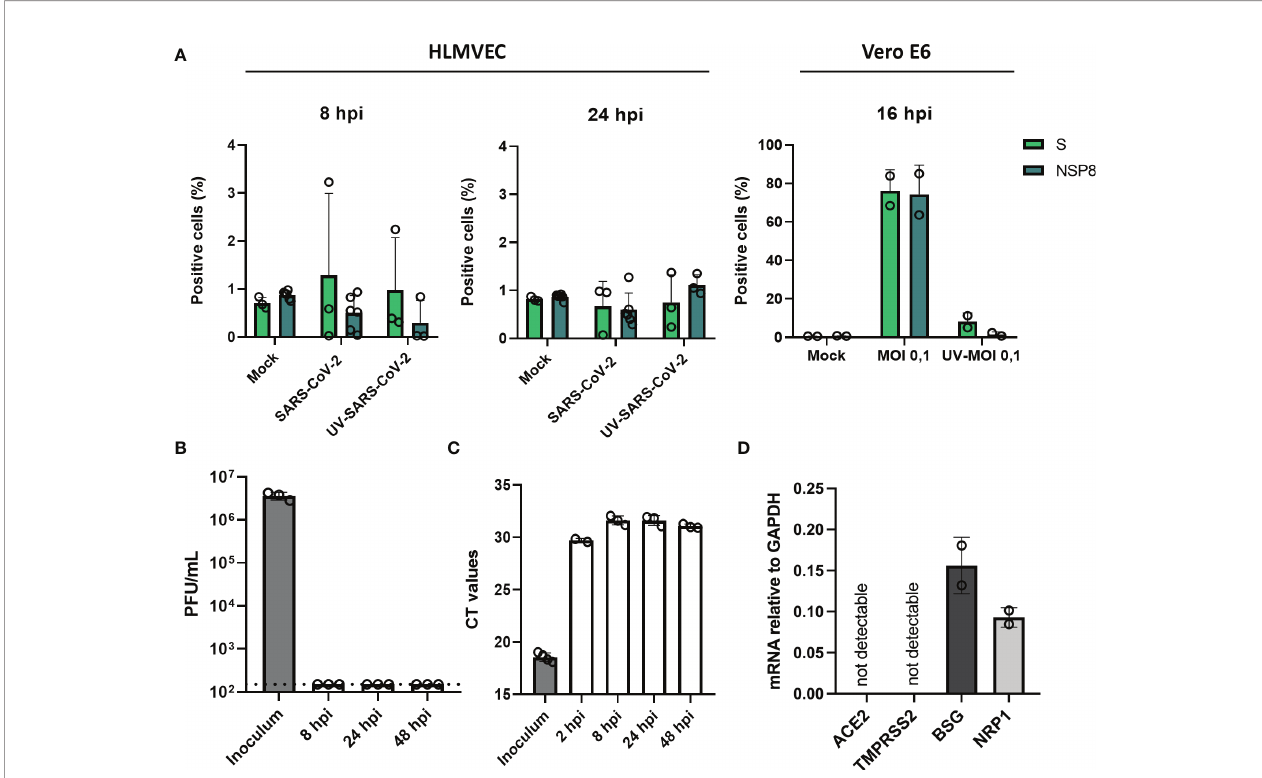
FIGURE 1 | SARS-CoV-2 does not infect HLMVEC. HLMVEC were inoculated with SARS-CoV-2 at MOI 5 for 8, 24 and 48 hr and Vero E6 cells were inoculated for 16 hr. (A) Percentage of infected cells was determined in HLMVEC 8 and 24 hpi and Vero E6 cells 16 hpi by the protein expression of NSP8 and S determined by fl ow cytometry. The production of new infectious virus (B) and viral RNA (C) was determined at 8, 24 and 48 hpi by plaque assay and qPCR respectively. The dotted line indicates the threshold of detection. Data are represented as mean ± SD of at least three independent experiments. Each symbol represents data from a single independent experiment. (D) The mRNA levels of ACE2, TMPRSS2, BSG and NRP1 were obtained by RT-qPCR. Gene expression values were normalized to the expression of the housekeeping gene GAPDH. Student T tests were used to evaluate statistical differences and a p value ≤ 0.05 was considered signi fi cant with *p ≤ 0.05, **p ≤ 0.01 and ***p ≤ 0.001. In the absence of ‘ * ’ the data is non-signi fi